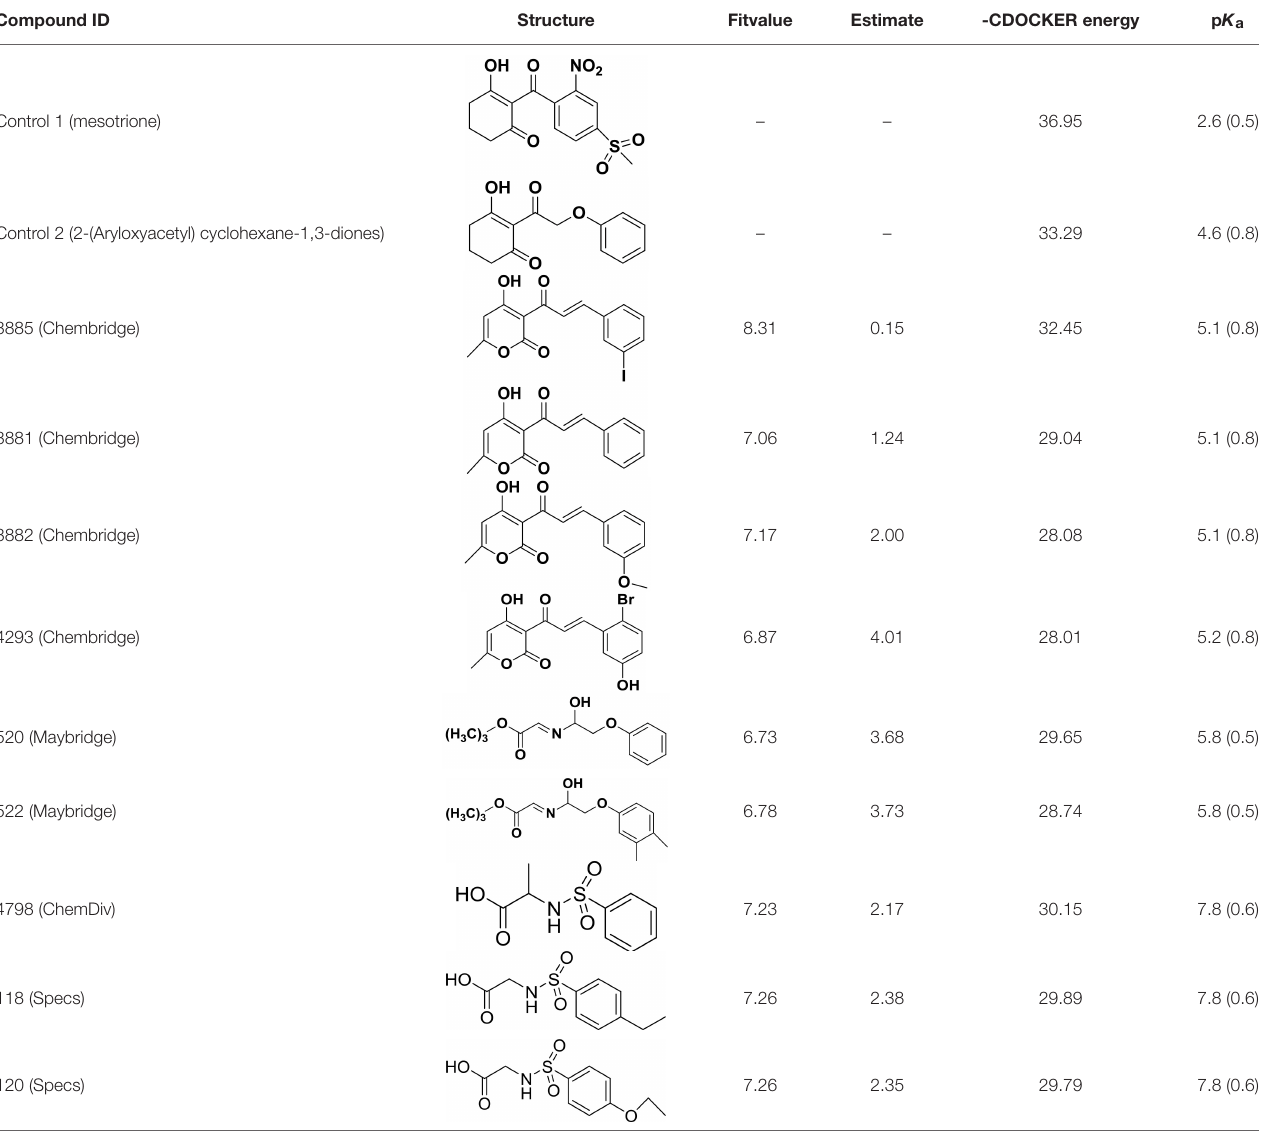
TABLE 2 | The 2D structure of the potential HPPD Inhibitors and the evaluation value. Compound ID Structure Fitvalue